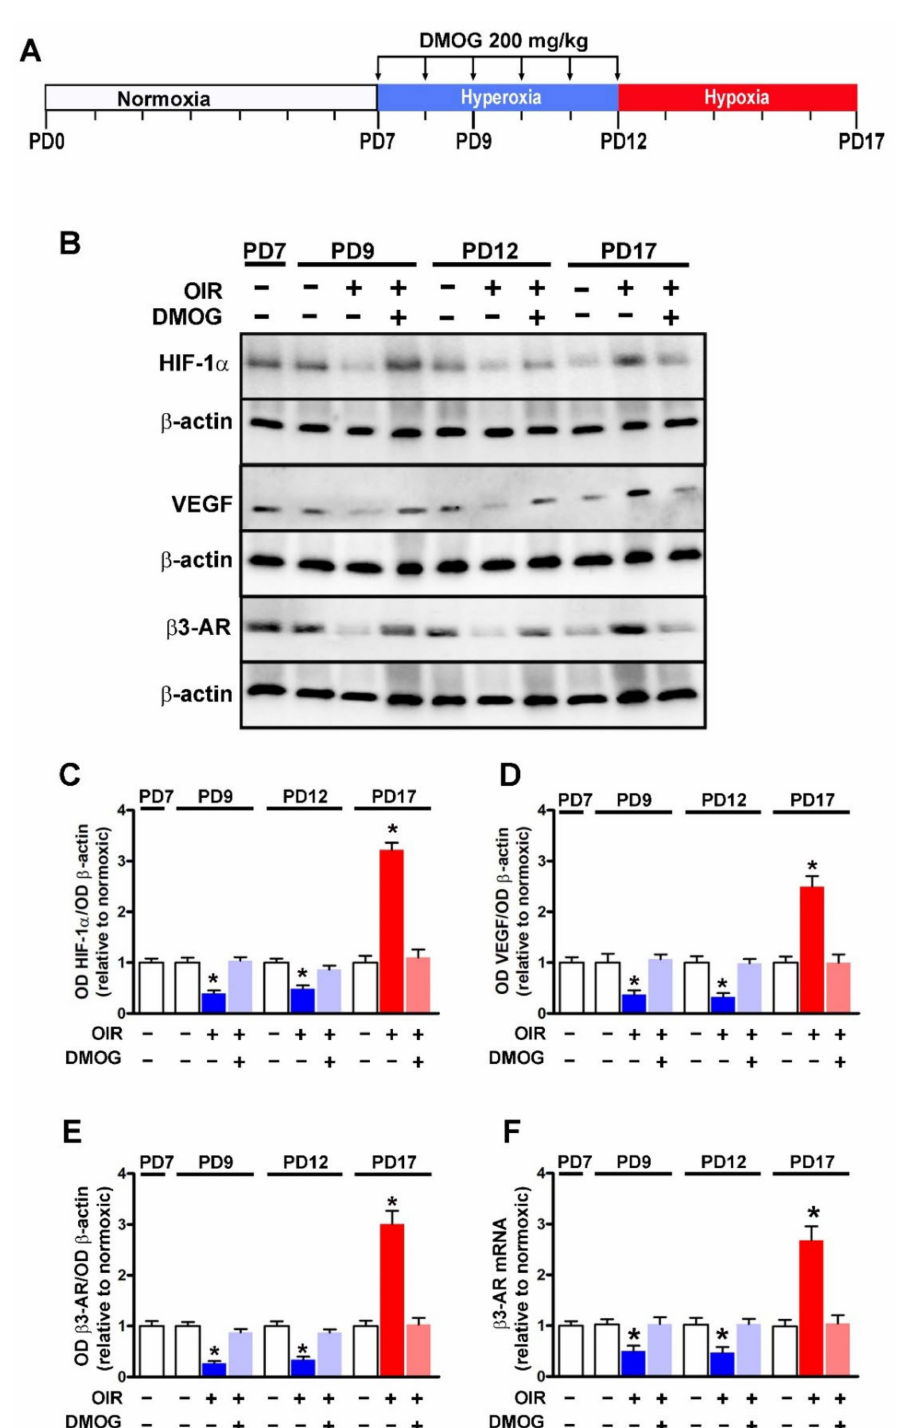
Figure 1. Effects of oxygen tension on retinal levels of HIF-1 α , VEGF and β 3-AR from PD7 to PD17. ( A ) Schematic diagram of the OIR model including DMOG administration daily from PD7 to PD12. ( B ) Representative blots showing protein levels of HIF-1 α , VEGF and β 3-AR as evaluated by Western blot in retinal extracts at different times from normoxic controls or OIR mice without or with DMOG administration. β -actin was used as the loading control. ( C – E ), Relative densitometric analyses of the protein levels of HIF-1 α , VEGF and β 3-AR. ( F ) Retinal mRNA levels of β 3-AR at different times from controls or OIR mice untreated or treated with DMOG. * p < 0.05 vs. normoxic controls. One-way ANOVA followed by Tukey’s multiple comparison post-hoc test. Each histogram represents the mean ± SEM of data from 6 independent